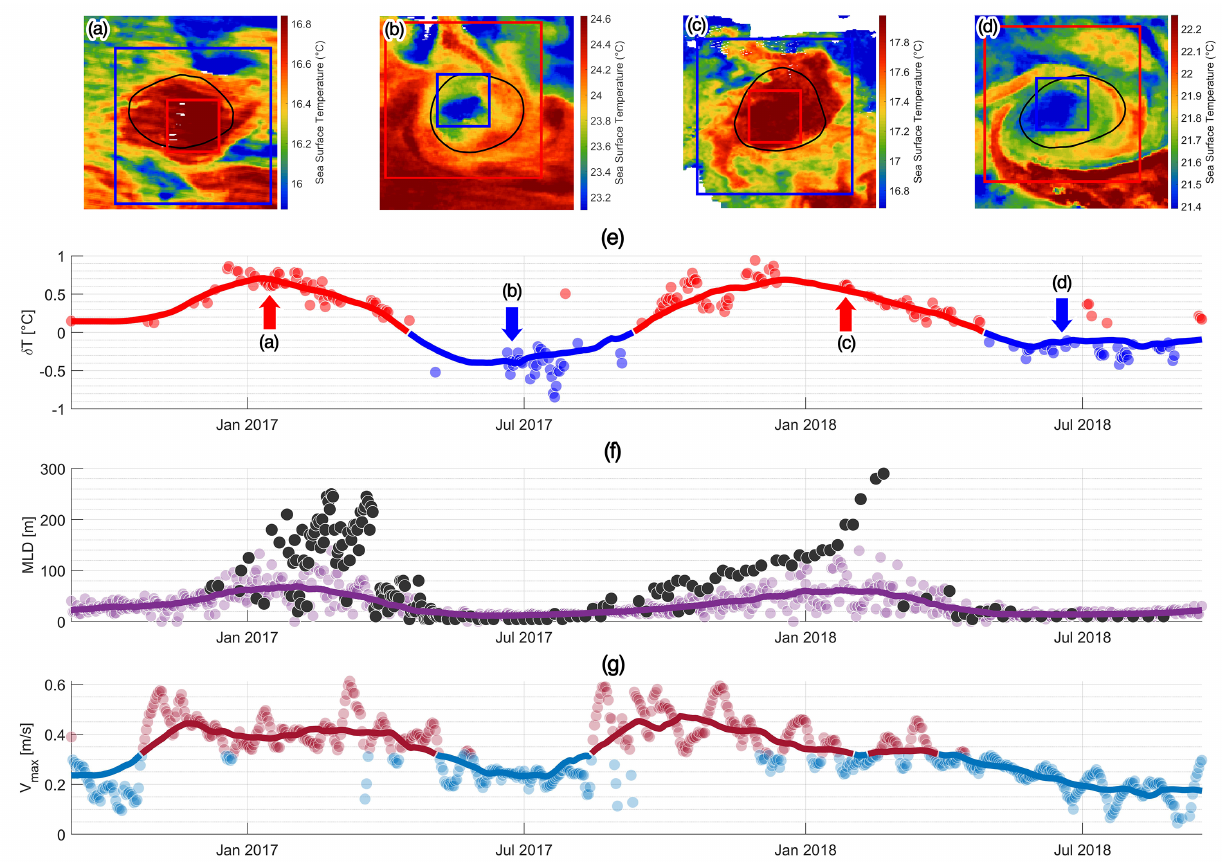
Figure 8. Timeline of the Ierapetra anticyclone with DYNED ID #11099. Four characteristic SST patches are shown in panels ( a – d ) which correspond to different regimes of the evolution of the eddy SST anomaly. In panel ( e ), the δ T index values are plotted for every retained observation with red (blue) dots for positive (negative) values. The Monthly Mean Average of these values is plotted with a red (blue) line showing the regime change between a Warm Core and a Cold Core eddy. On panel ( f ), the depth of the mixed layer (MLD) is plotted with pink dots for values outside the eddy and black dots inside the Ierapetra eddy. A Monthly Mean Average of the MLD evolution outside the eddy is plotted with a pink line. On panel ( g ), the surface maximal velocities ( V max ) for each timestep in the DYNED-Atlas eddy track are plotted with dots and their Monthly Mean Average is plotted with a line. Velocities are plotted with magenta (cyan) when they are higher (lower) than the mean velocity in the eddy